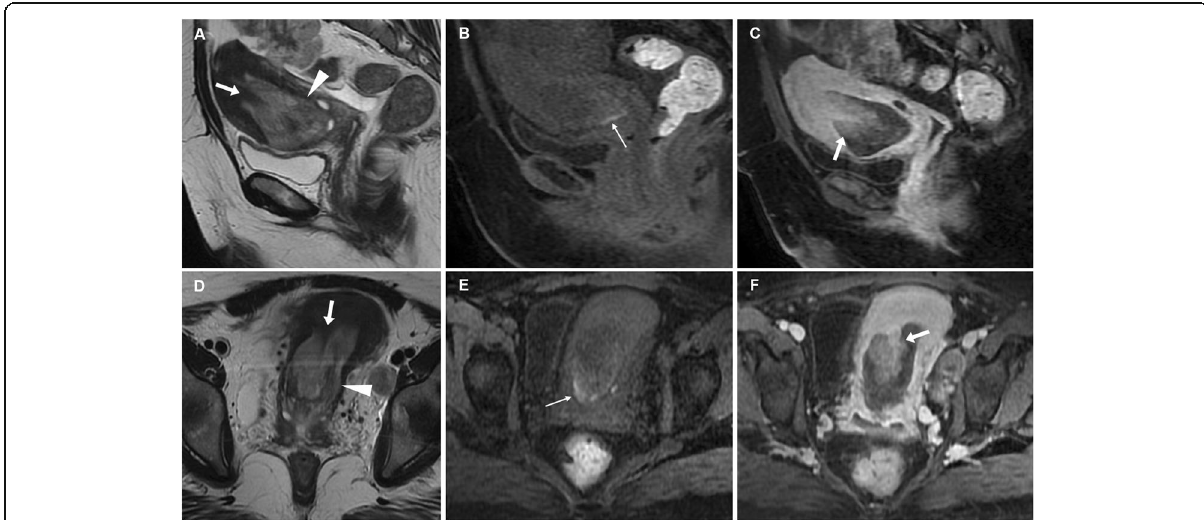
Fig. 1 Endometrial polyp in a 44-year-old woman with acute uterine bleeding and associated bilateral ovarian neoplasm. Sagittal ( a ) and oblique- coronal ( d ) T2-weighted images show a huge polypoid mass (arrowheads) arising from the uterine fundus that fills the endometrial cavity and protrudes into the cervical canal. Note the hypointense stromal axis of the polyp (arrows). Corresponding sagittal ( b ) and oblique-coronal ( e ) precontrast fat-suppressed T1-weighted images show hyperintense foci on the polyp edge (thin arrows), representing haemorrhage. On gadolinium-enhanced sagittal ( c ) and oblique-coronal ( f ) fat-suppressed T1-weighted images, the implant base (stromal axis) of the polyp shows intense enhancement (arrows). The patient underwent bilateral uterine artery embolisation in order to control bleeding